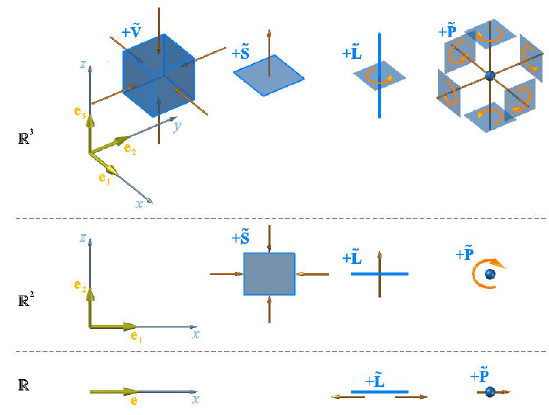
Figure 27: Positive and negative outer orientations of a volume. The outer orientation of a line is useful for describing, for example, the rotatory polarisation of a light beam. The heat that crosses a surface, the surface forces in continuum mechanics, the mass current, the energy cur- rent, and the charge current are examples of surface vari- ables whose sign depends on the crossing direction of the surface, that is, on the outer orientation of the surface to which they are related.